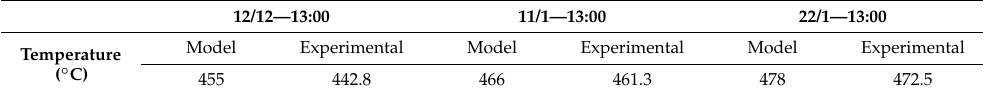
Table 4. Average temperature values in the middle of the receiver.